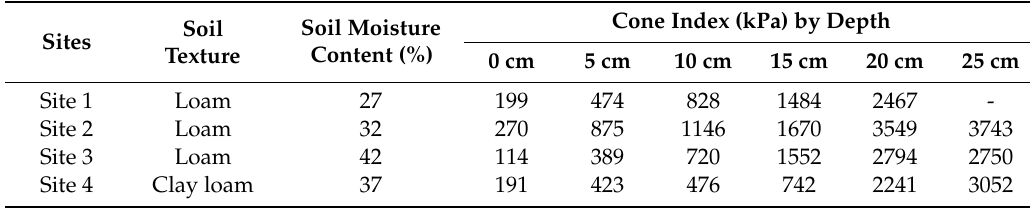
Table 4. Physical properties of soil for each field site.